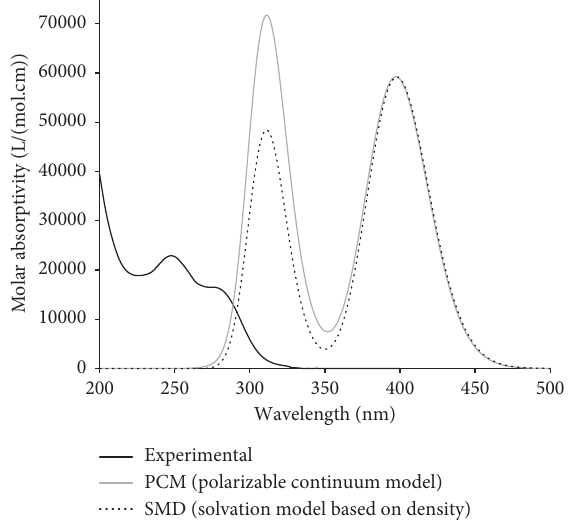
Figure 2: The UV-Vis absorption spectrum of 1x10 − 5 M (in methanol) ibrutinib and the density functional theory calculations using two solvation techniques: PCM and SMD. The comparative spectra provide important electronic and orbital information about the